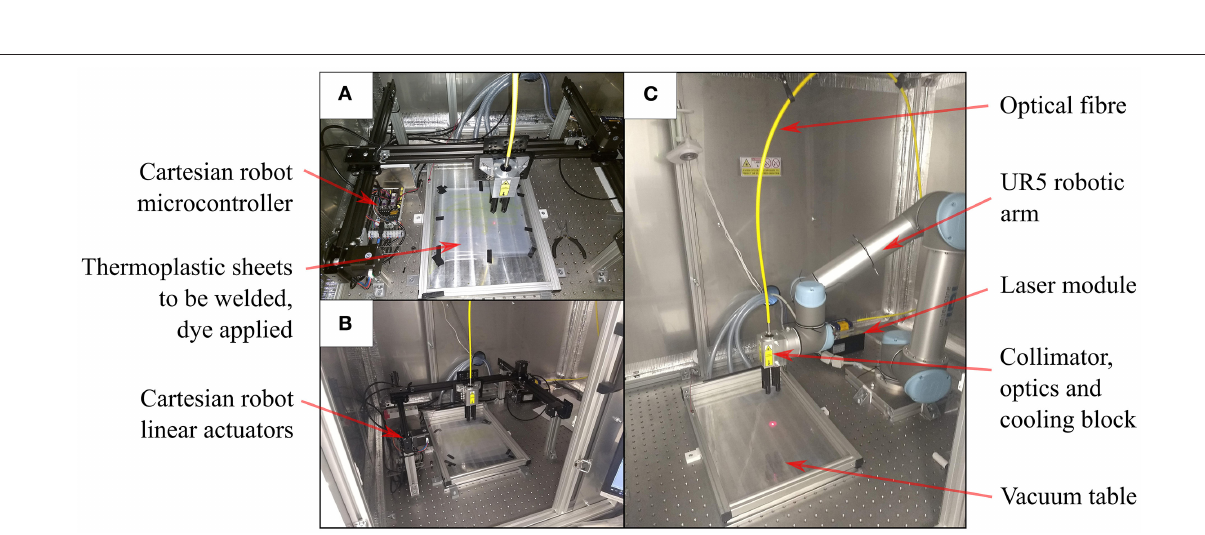
weld pattern design and heat sealed onto the thermoplastic sheet using a hot air gun and heat shrink sleeve. This was chosen because it resulted in fast, economical and low- profile